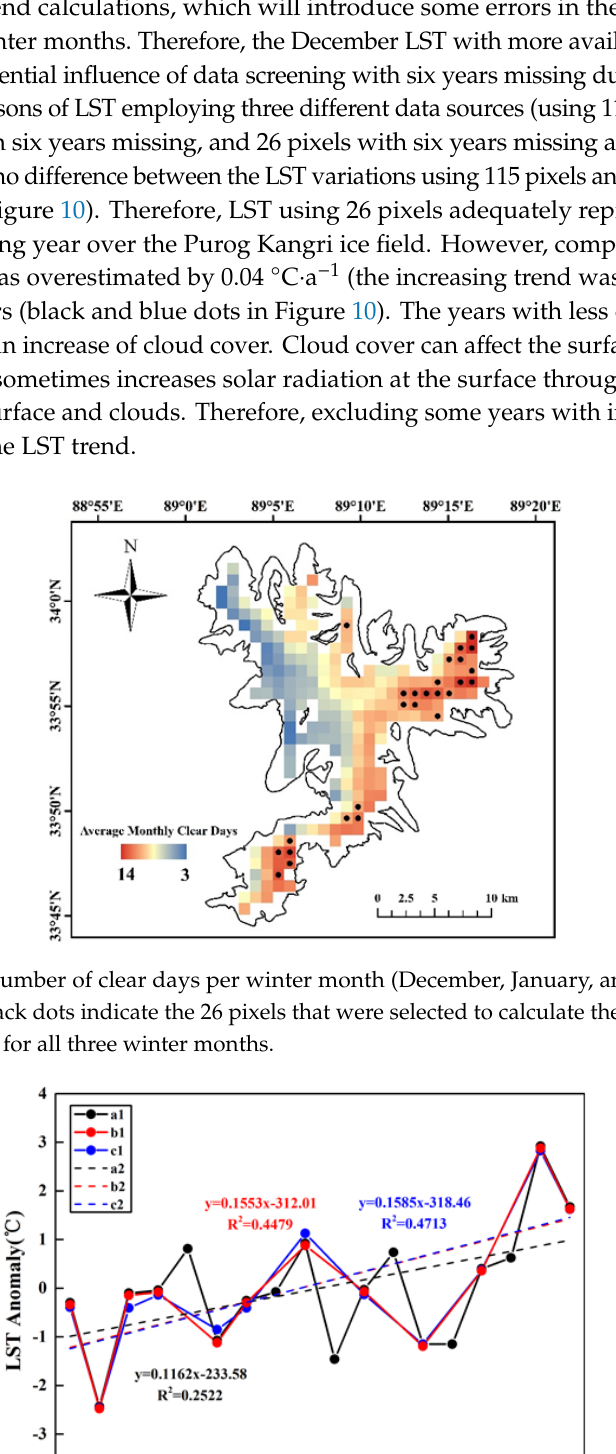
Figure 10. Variations in the December LST (land surface temperature) anomalies (dots) and their linear trends (dashed lines) under di ff erent conditions. Those using 115 pixels with no missing years are shown in black (a1 and a2), those using 115 pixels with six years missing are shown in red (b1 and b2), and those using 26 pixels (as used in January and February) with six years missing are shown in blue (c1 and